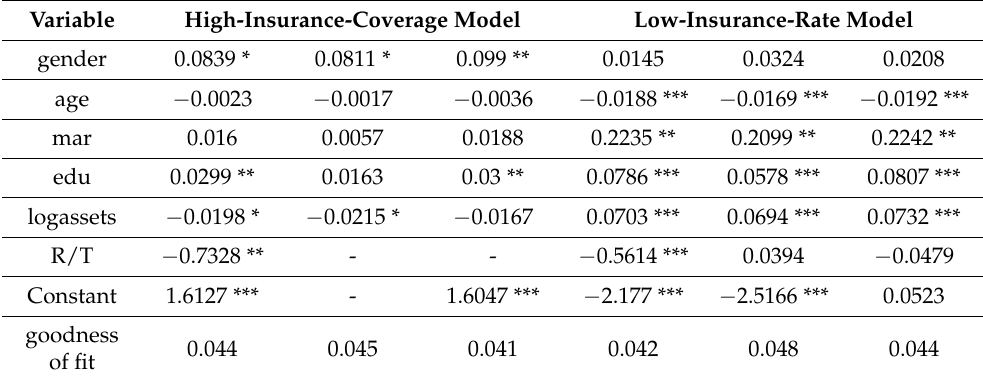
Table 2. Model regression results of high and low insurance rate models.